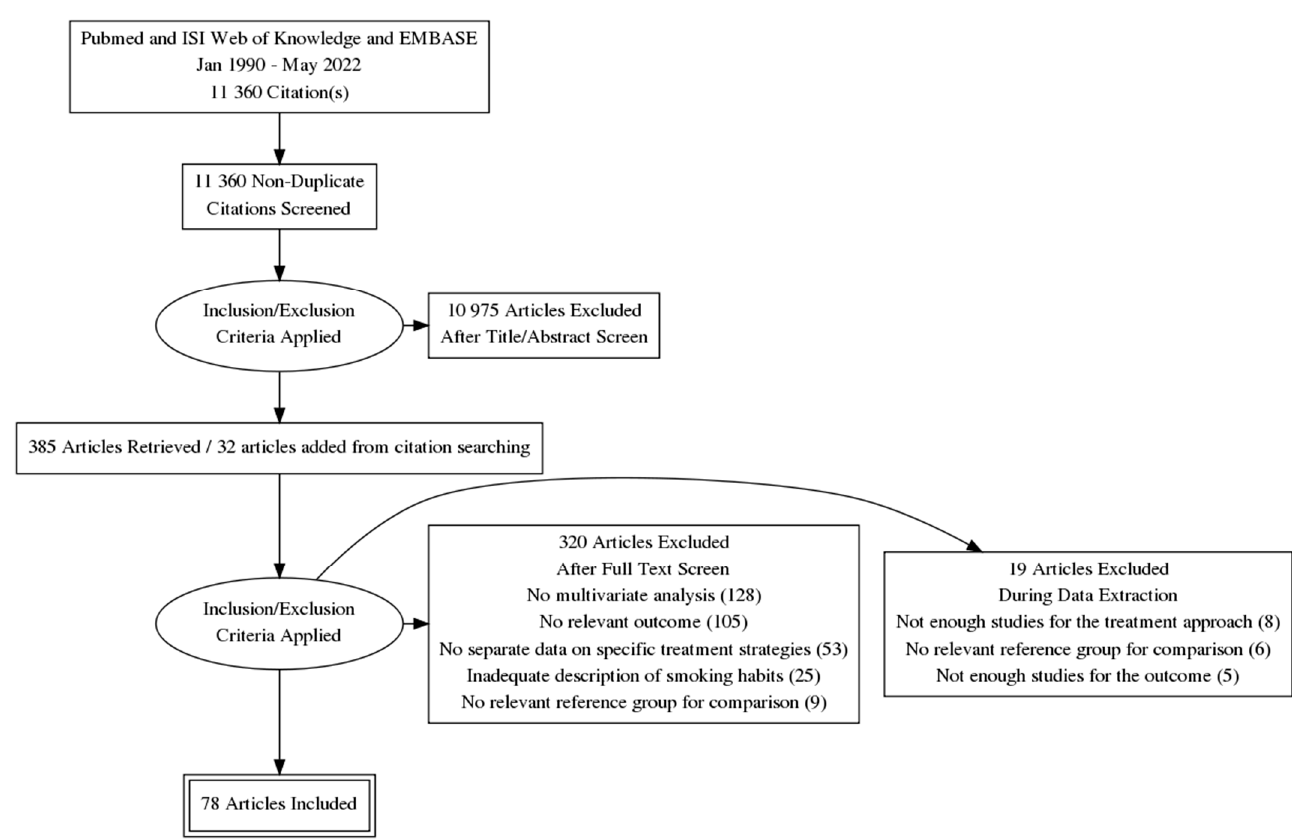
Figure 1. Flowchart diagram of study selection process.